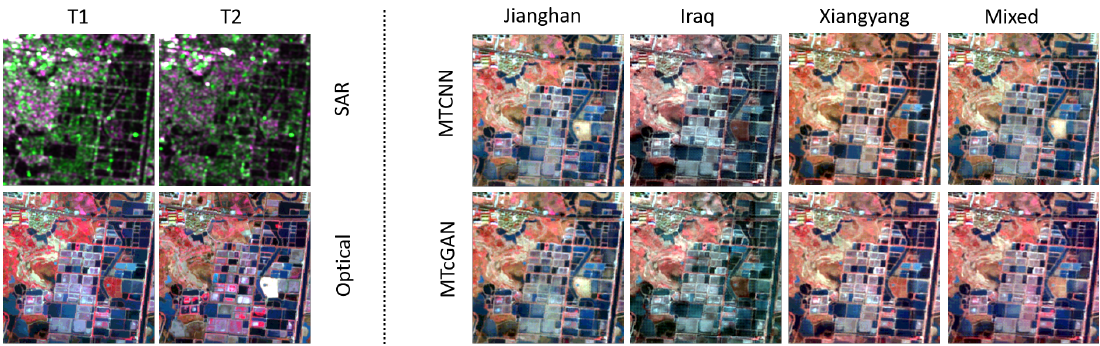
Figure 8. Simulated images of different methods in Case 2. The input images (S1, S2 and O1) and output reference image (O2) on the left side, and simulated images with different training samples on the right